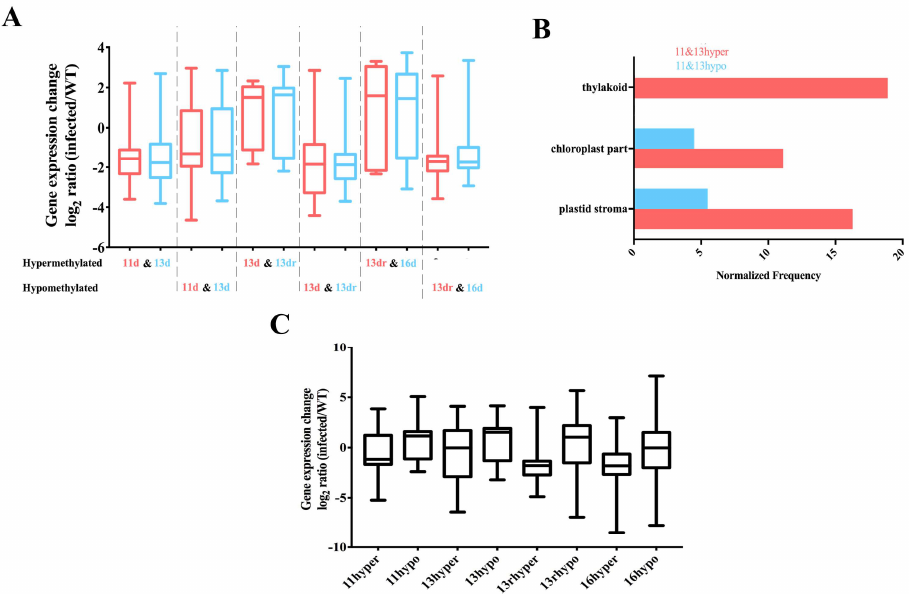
Figure 3. Stable DMRs across the developmental stages. ( A ) Expression levels of all protein-coding genes defined to be regulated at the nearby stages. Fold change were calculated from two biological replicates; ( B ) Gene ontology enrichment analysis of stable DMRs covered genes at 11 d and 13 d. Values along the x-axis represent the normalized frequency (relative frequency of the inquiry set/relative frequency of the reference set), and the enrichment cutoff was greater than 1.5-fold. The p -values of all the enriched pathways were less than 0.01; ( C ) Expression levels of all protein-coding genes found to be regulated at their promoter. Fold changes were calculated from two biological replicates.